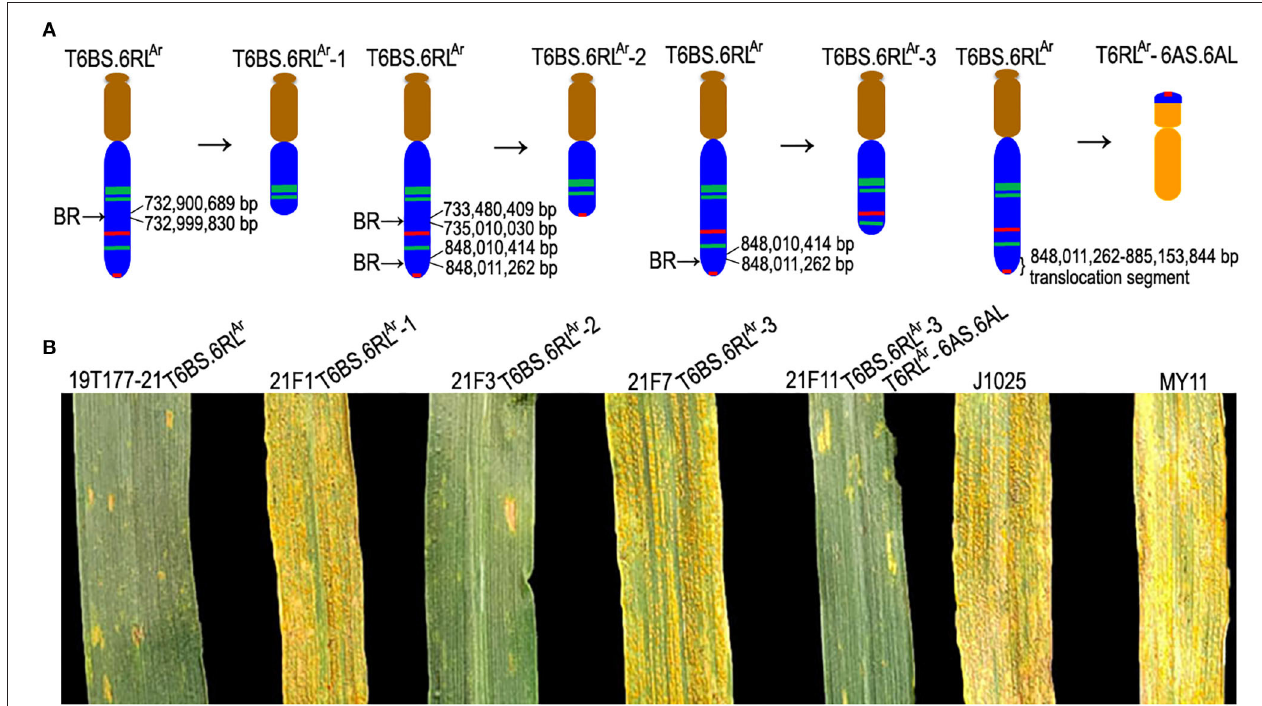
FIGURE 5 | Ideograms of wheat-rye 6RL translocation chromosomes and stripe rust response test. (A) Ideograms of T6BS.6RL Ar , deleted T6BS.6RL Ar, and the small-segment translocation T6RL Ar -6AS.6AL. Brown, blue, and orange indicate segments of 6B, 6R, and 6A chromosomes, respectively. Green and red bands indicate the signals of Oligo-pSc119.2-1 and Oligo-pSc200, respectively. “BR” indicates a break point. The right brace indicates the 6RL Ar segment that was transferred on the 6A chromosome. (B) Parental wheat J1025 and MY11 and lines 21F1 and 21F7 were highly susceptible to stripe rust and lines 19T177-21, 21F3, and 21F11 were highly